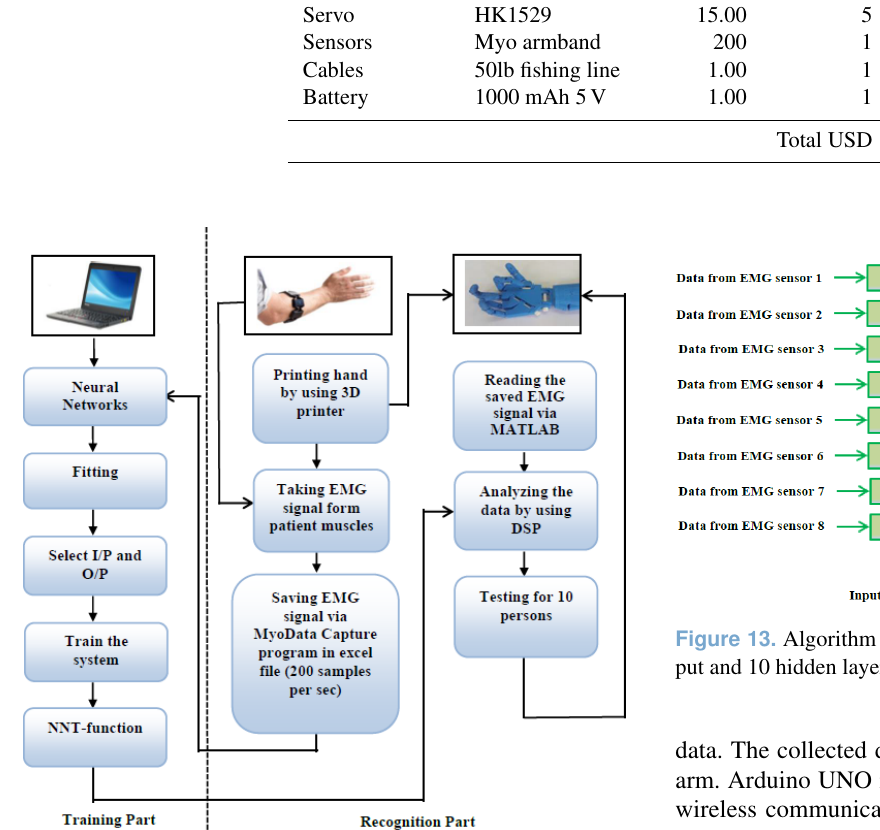
Figure 12. Flowchart of the main controller software.